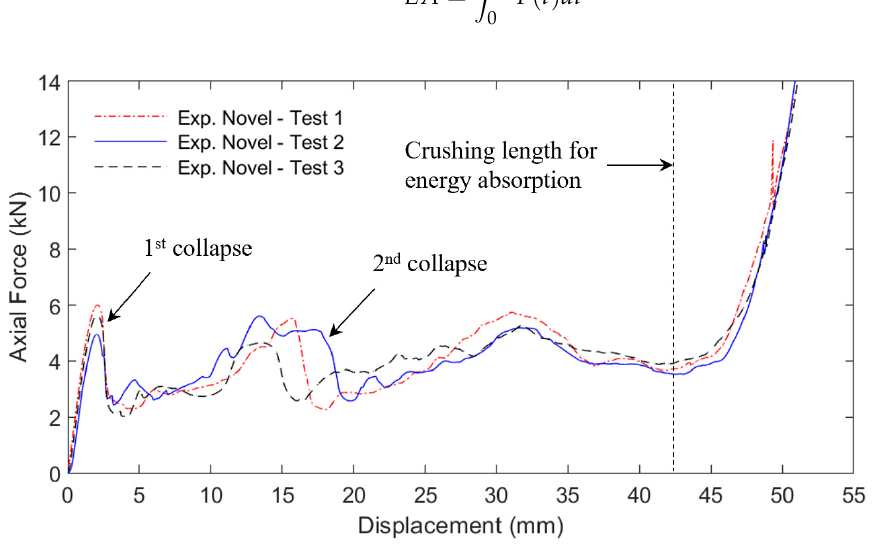
Figure 7. Experimental load vs. displacement curves for novel cell under axial load.